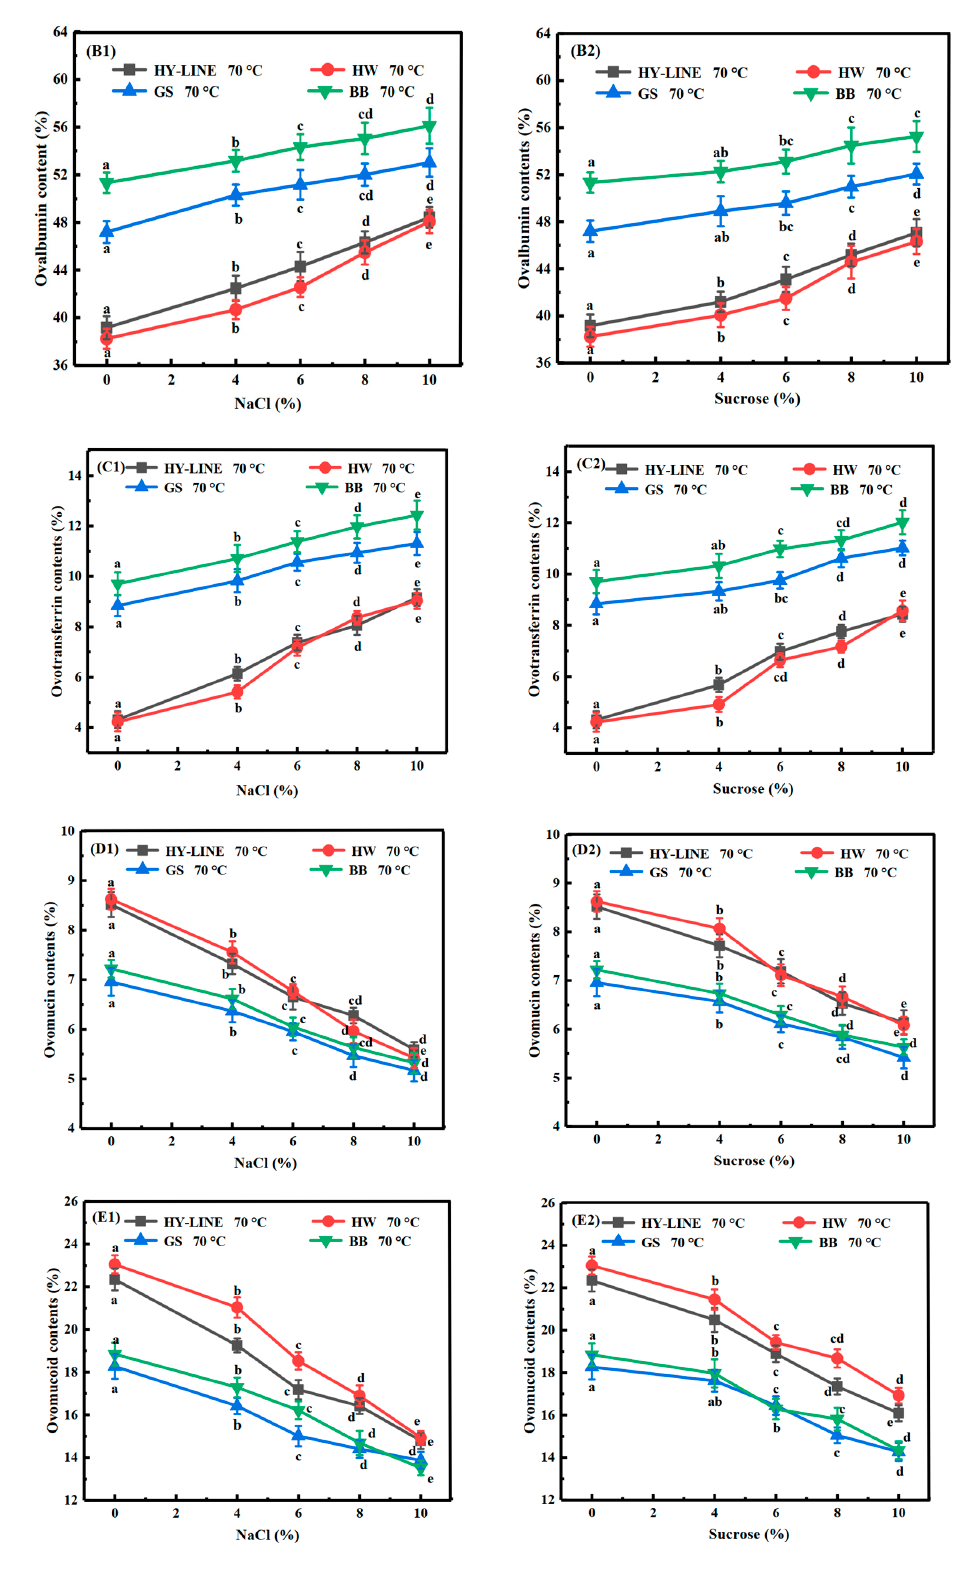
Figure 2. Contents of different proteins in four varieties of EWs subjected to heat treatment. ( A1 ) Lysozyme; ( B1 ) ovalbumin; ( C1 ) ovotransferrin; ( D1 ) ovomucin; ( E1 ) ovomucoid in four varieties of EW with different NaCl concentrations after heat treatment. ( A2 ) Lysozyme; ( B2 ) ovalbumin; ( C2 ) ovotransferrin; ( D2 ) ovomucin; ( E2 ) ovomucoid in four varieties of EWs with different sucrose concentrations after heat treatment. Three replicate samples were measured for each